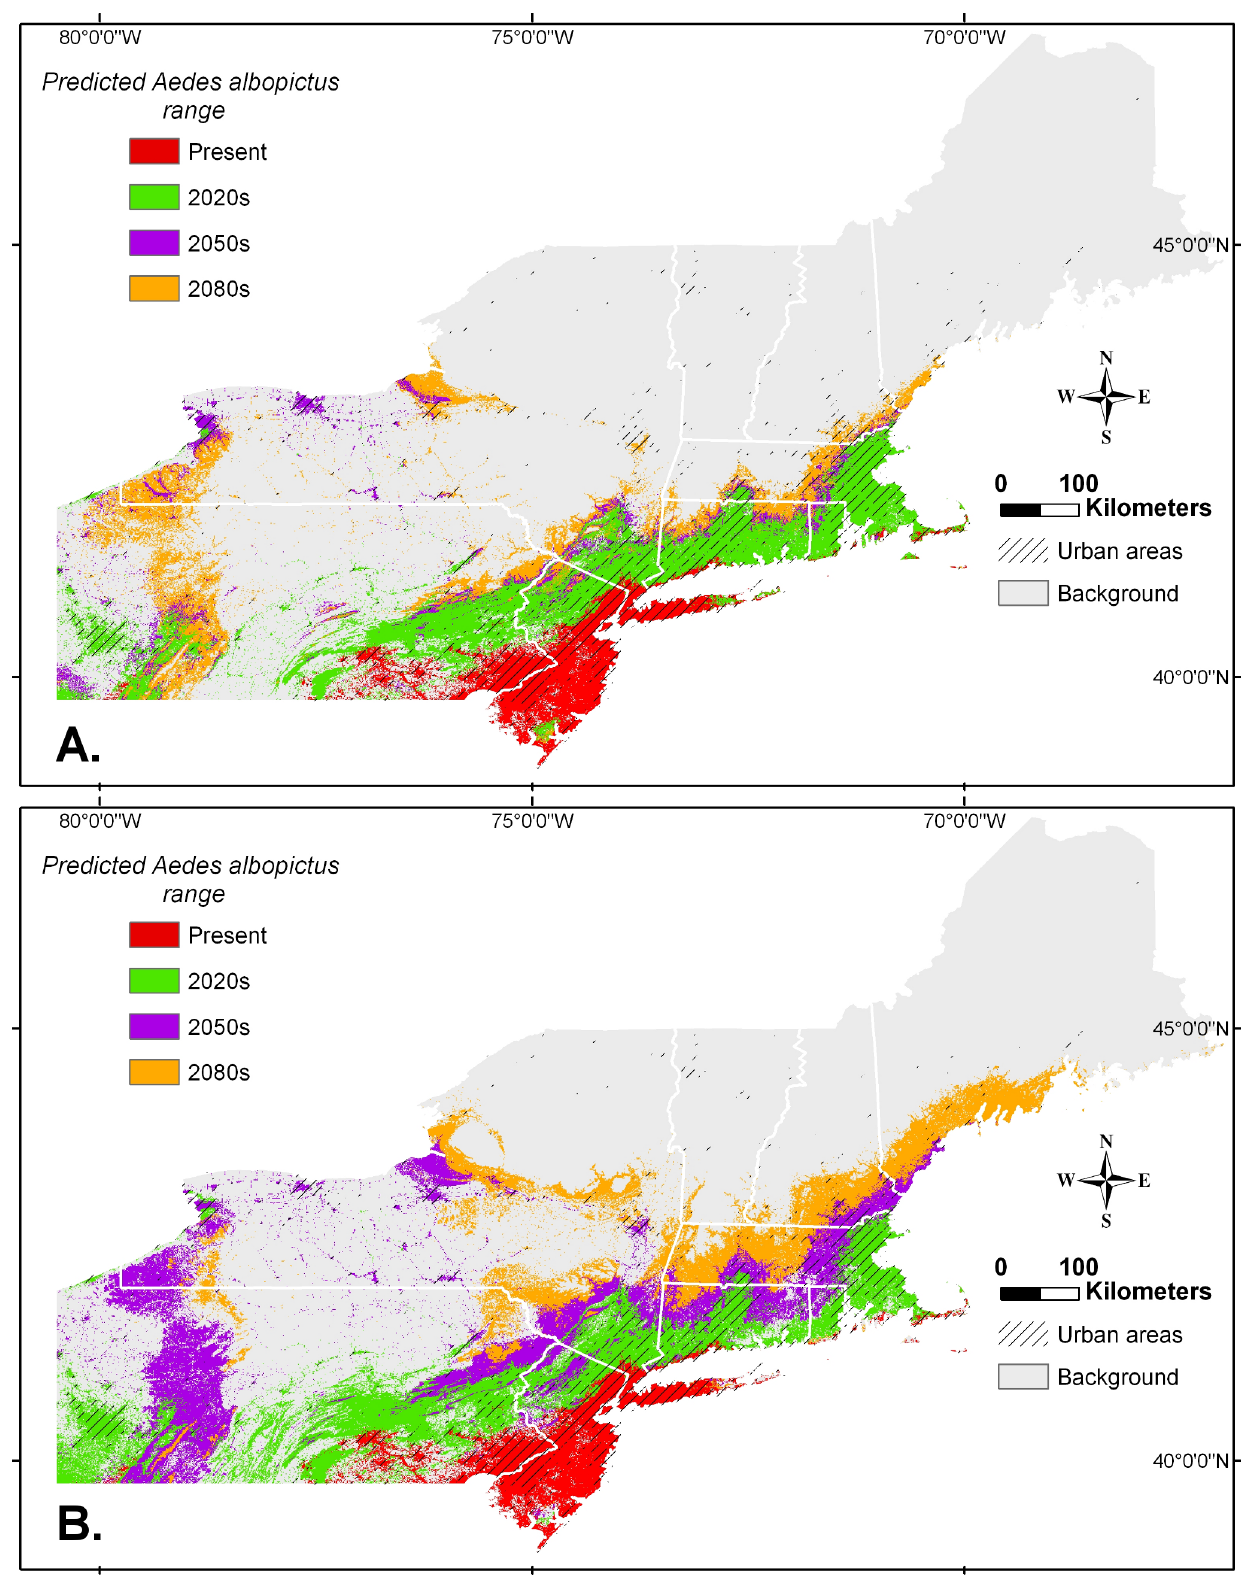
Figure 2. Predicted Ae.albopictus range expansion in the northeastern USA under two climate change scenarios. ( A ) Moderate increase in CO2 emissions (B2 scenario). ( B ) Higher increases in CO 2 emissions (A2 scenario). Predicted present range based on 1950–2000 climate data. Three future time periods: 2020s (years 2010–2039), 2050s (years 2040–2069), and 2080s (years 2070–2099). Urban areas are indicated (2010 US Census Bureau). doi:10.1371/journal.pone.0060874.g002 PLOS ONE | www.plosone.org 5 April 2013 | Volume 8 | Issue 4 |